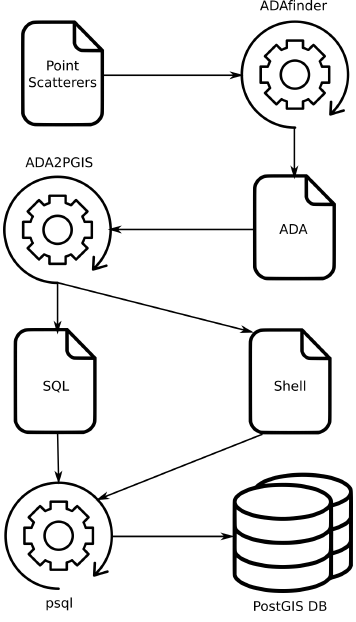
Figure 3. The data production workflow and